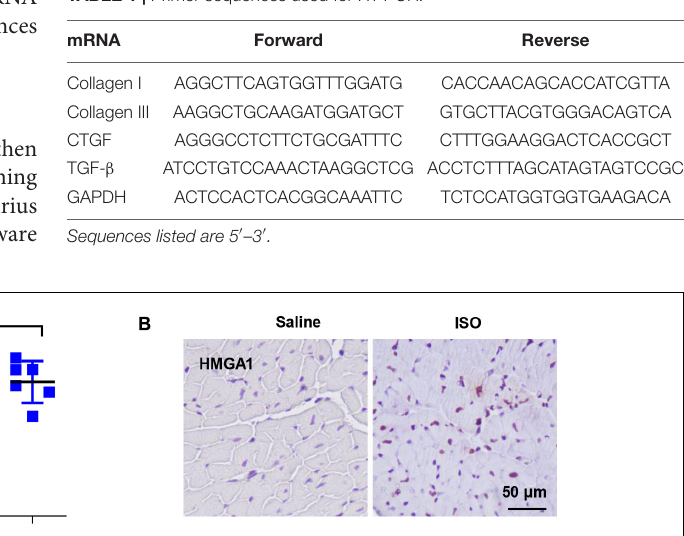
TABLE 1 | Primer sequences used for RT-PCR.